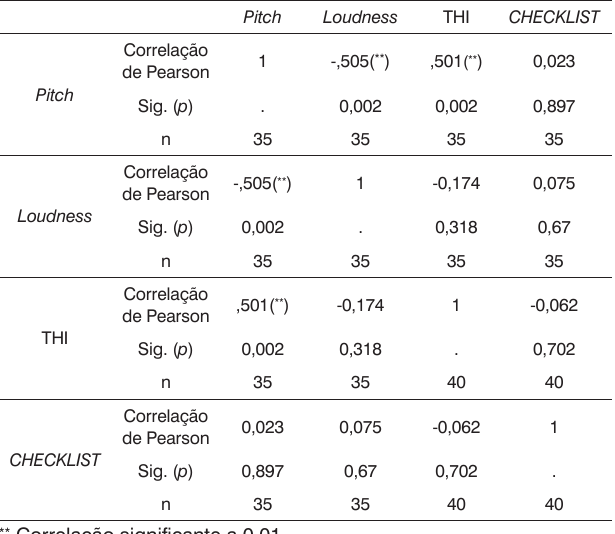
Tabela 6. Correlação entre os parâmetros pitch, loudness, THI e checklist.